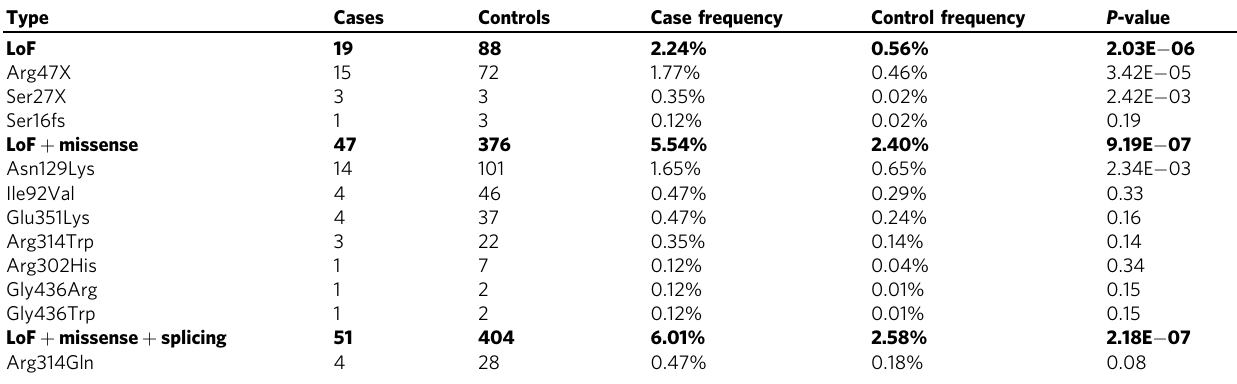
Table 2 Eleven damaging amino acid changes in KRT82 , the case and control frequencies and p -values.